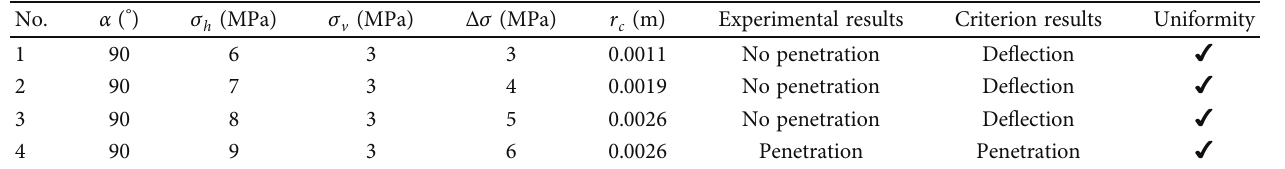
Table 3: Comparison of Jiang et al. ’ s experimental results and the results of the proposed